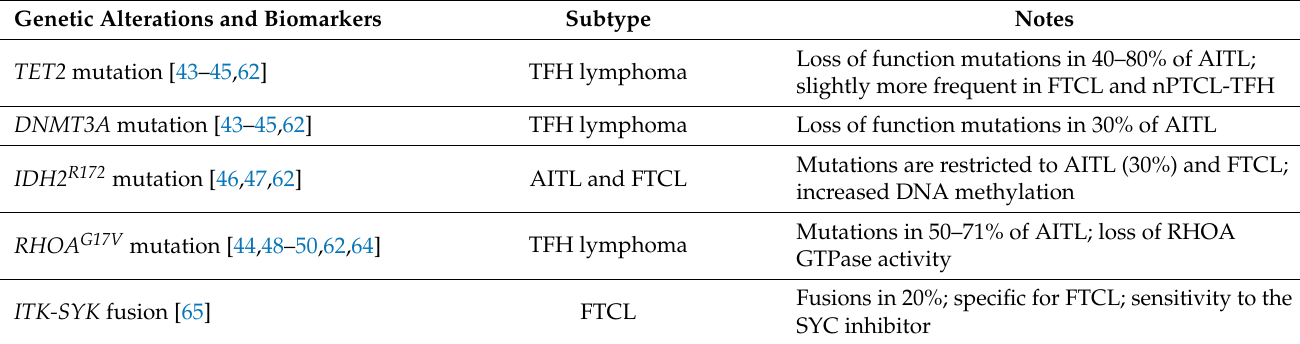
Table 3. Recurrent genetic alterations and key biomarkers of nodal TFH